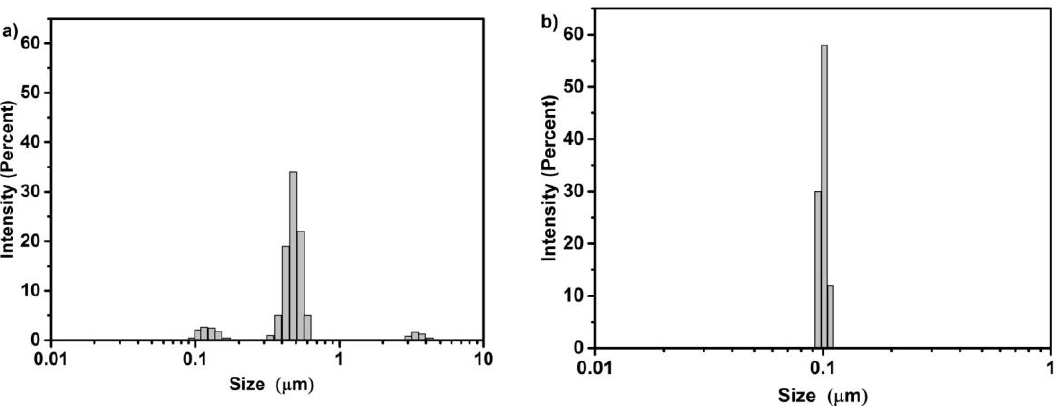
Figure 3. Particle size distribution in the aqueous suspensions of montmorillonite before ( a ) and after ( b ) mechanical treatment.